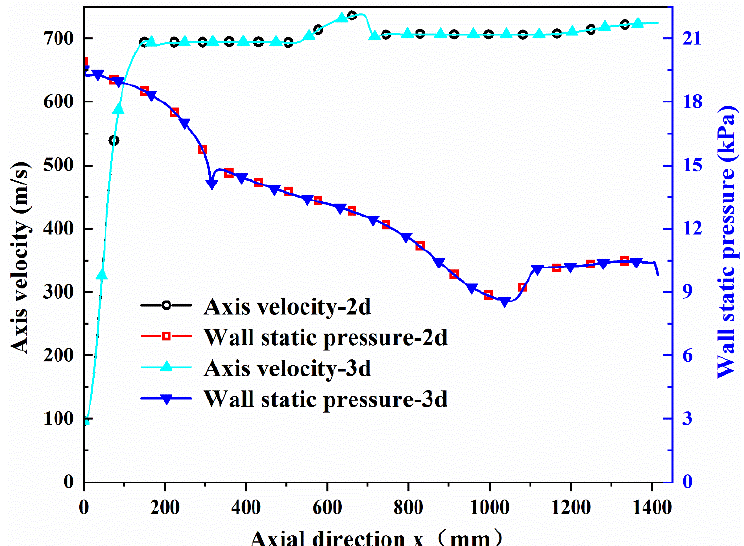
Figure 6. Centerline velocity and near-wall pressure comparison of 3D/2D models.